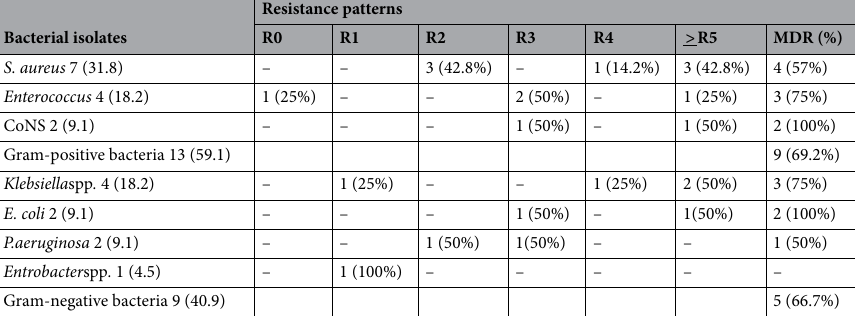
Table 4. Out of the 22 (n) total bacterial isolates, MDR was found in 15 (68.2%). Nine isolates (69.2%) belong to the Gram-positive catogery and five (66.7%) were Gram-negatives. The MDR patterns of Gram-positive bacte- ria consist of 4/7 (57.1%) of S. aureus , 3/4 (75%) of Enterococci species . and 2/2 (100%) of coagulase-negative Staphylococci. MDR patterns of Gram- negative bacteria comprise of 3/4 (75%) of Klebsiella species, 1/2 (50%) of P. aeruginosa and 2/2 (100%) of E. coli. Factors associated with bloodstream infections. In bivariable logistic regression analysis, BSI was